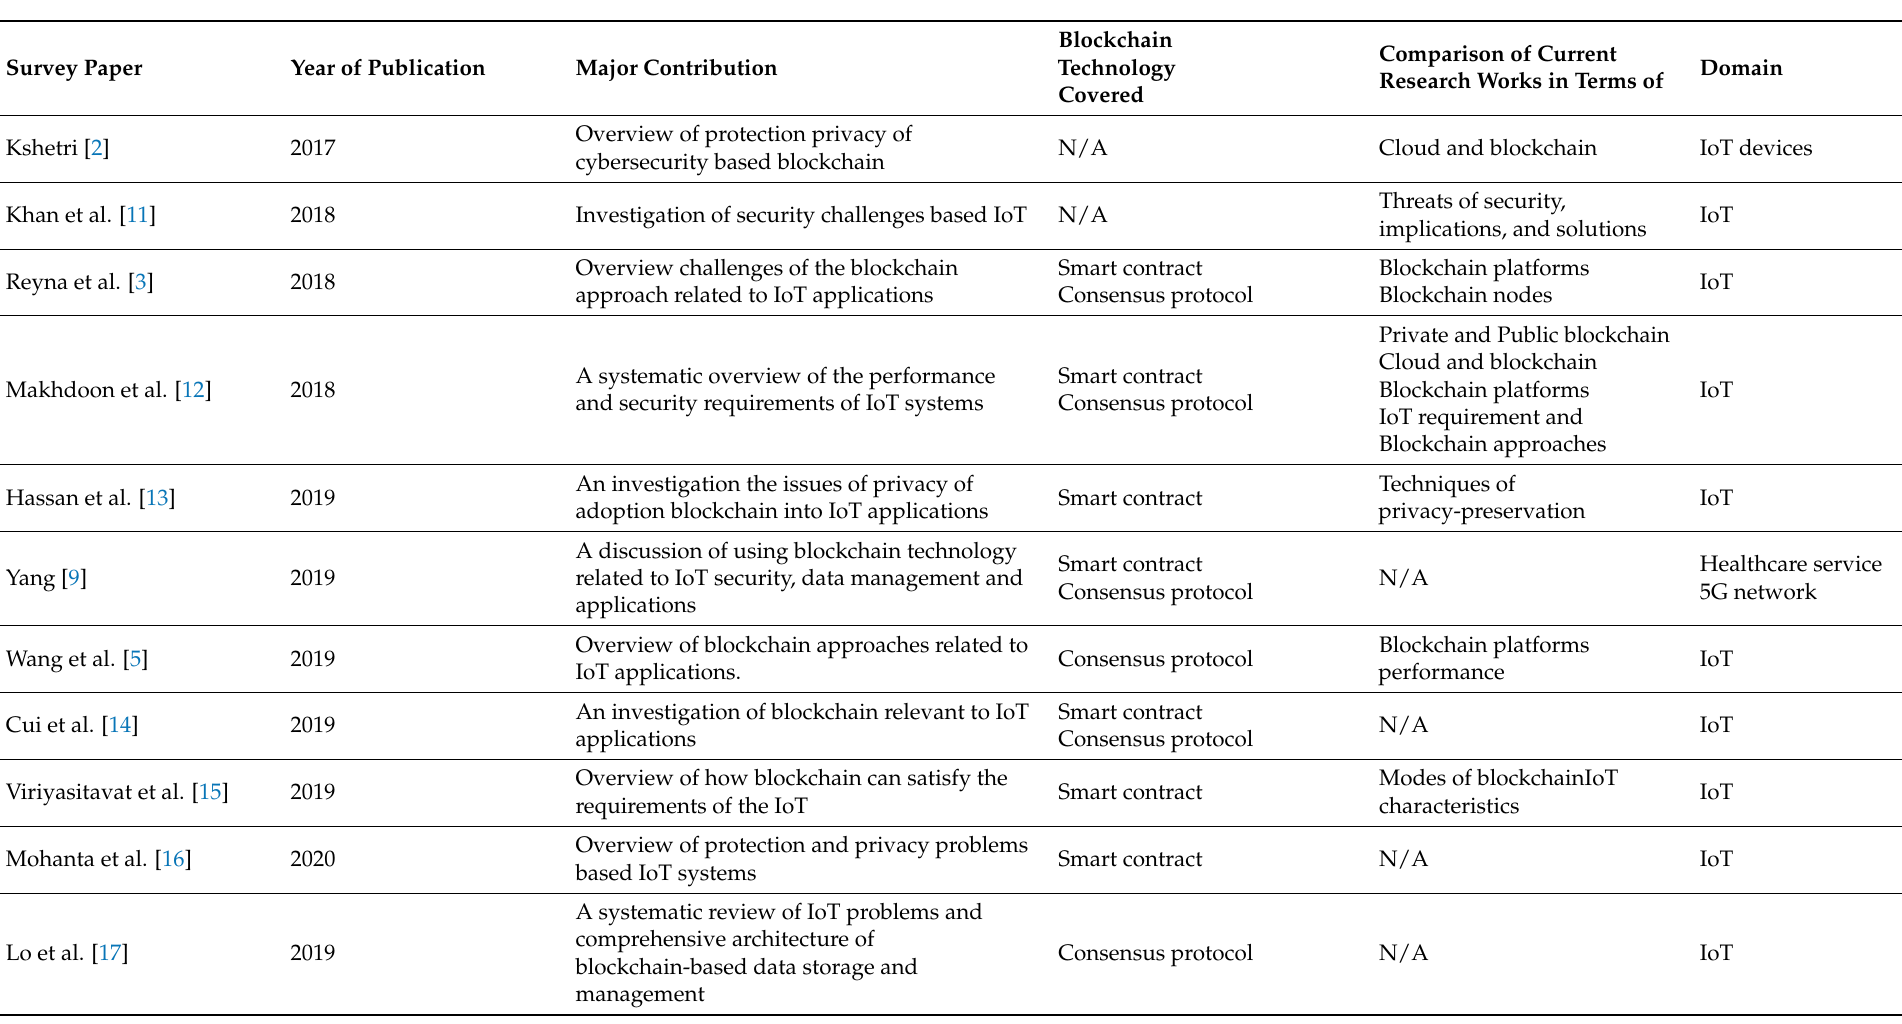
Table 1. Related